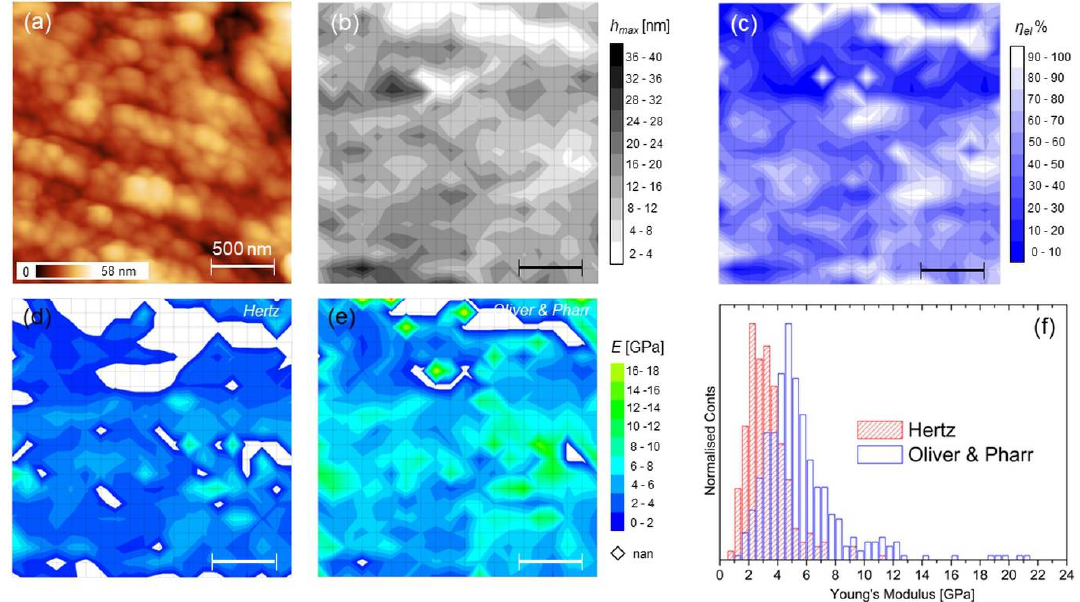
Figure 5. ( a – e ) The same as Figures. 4 and 5 for a 2 × 2 µm 2 large area (callus region); “nan” regions in the moduli maps were left intentionally blank; and ( f ) Histograms reporting the moduli distributions according to Hertz (red bars) and Oliver–Pharr (blue bars) models.